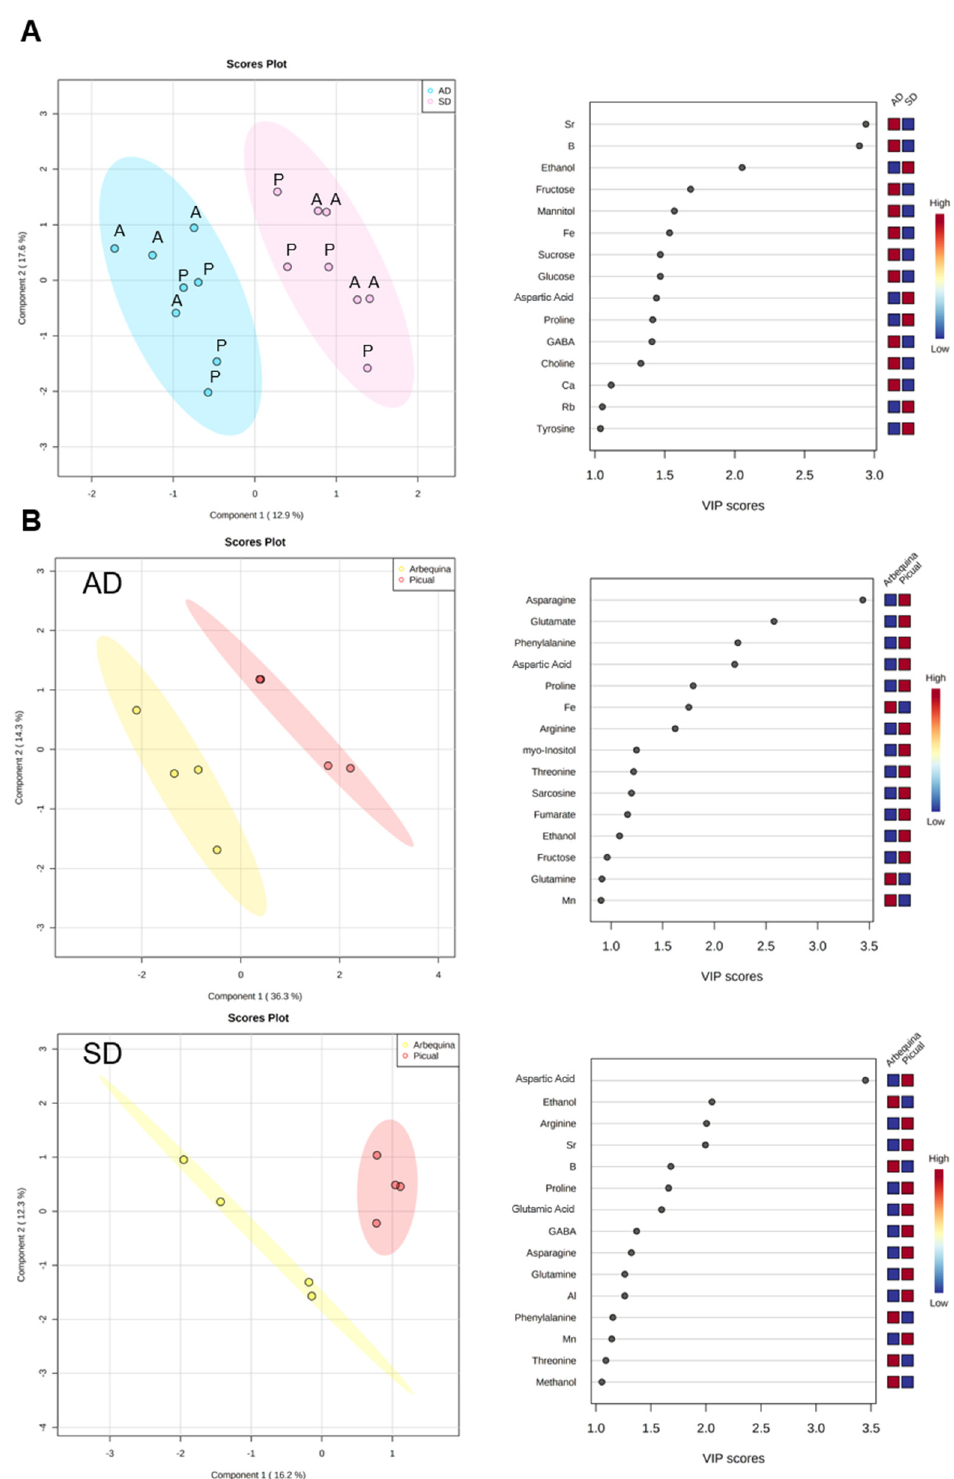
Figure 4. Partial least squares discriminant (PLS-DA) 2D score plot and loading importance in projection (VIP scores) in the first PLS-DA component of metabolomic and ionomic profile of olive xylem sap of plantlets (SD) and adult (AD) olive trees of ‘Picual’ (PIC) and ‘Arbequina’ (ARB) genotypes. ( A ) Combined analysis of all olive cultivars and plant age combinations. ( B ) Separate analysis by olive plant age.